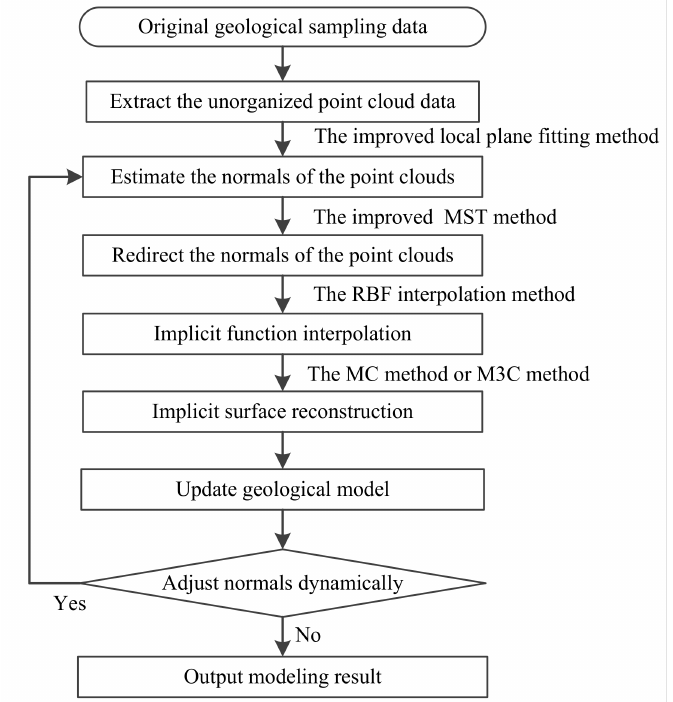
Figure 1. Overall flow chart of the method.